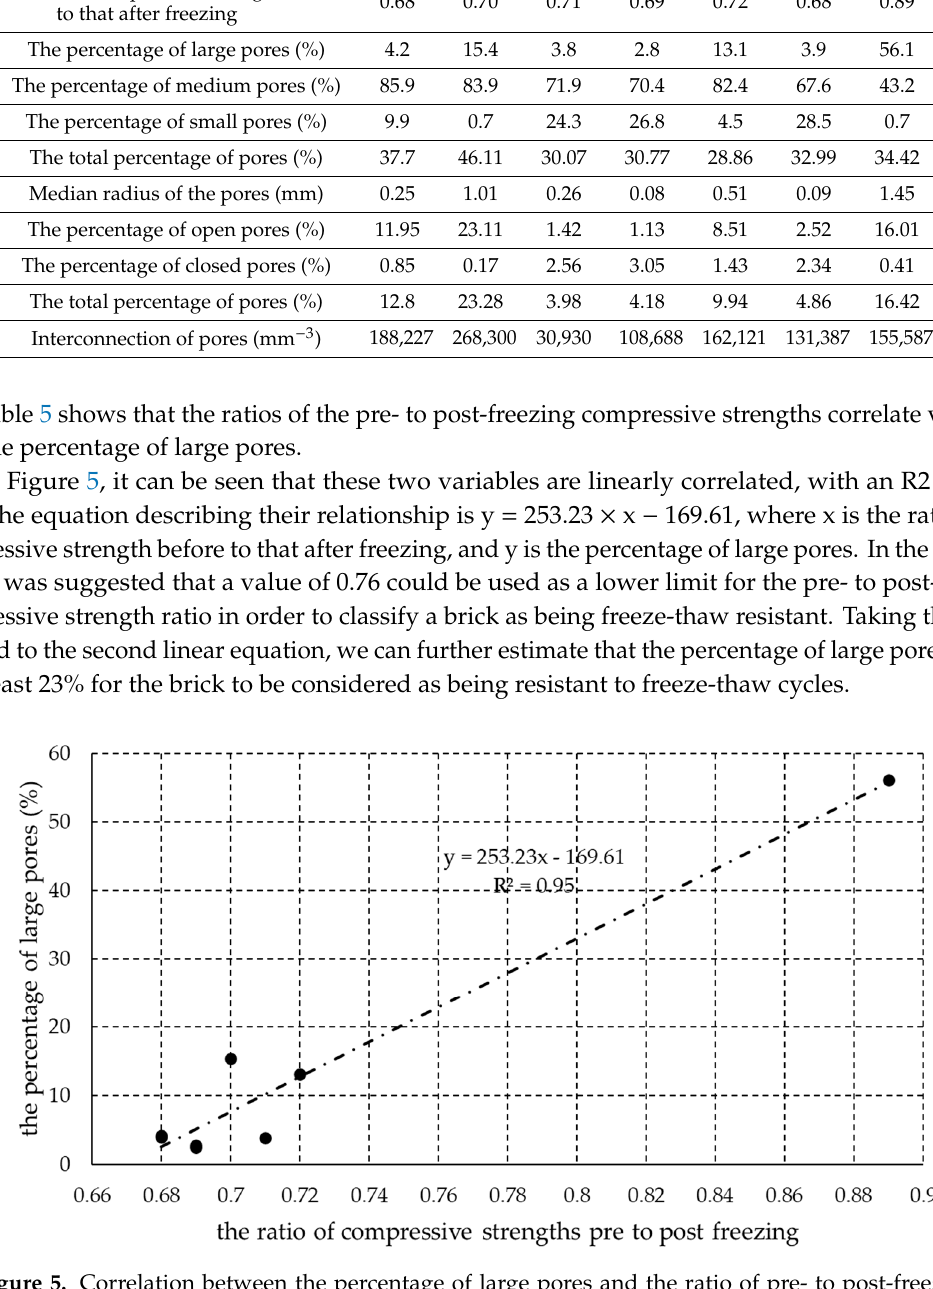
Figure 5. Correlation between the percentage of large pores and the ratio of pre- to post-freezing compressive strengths.